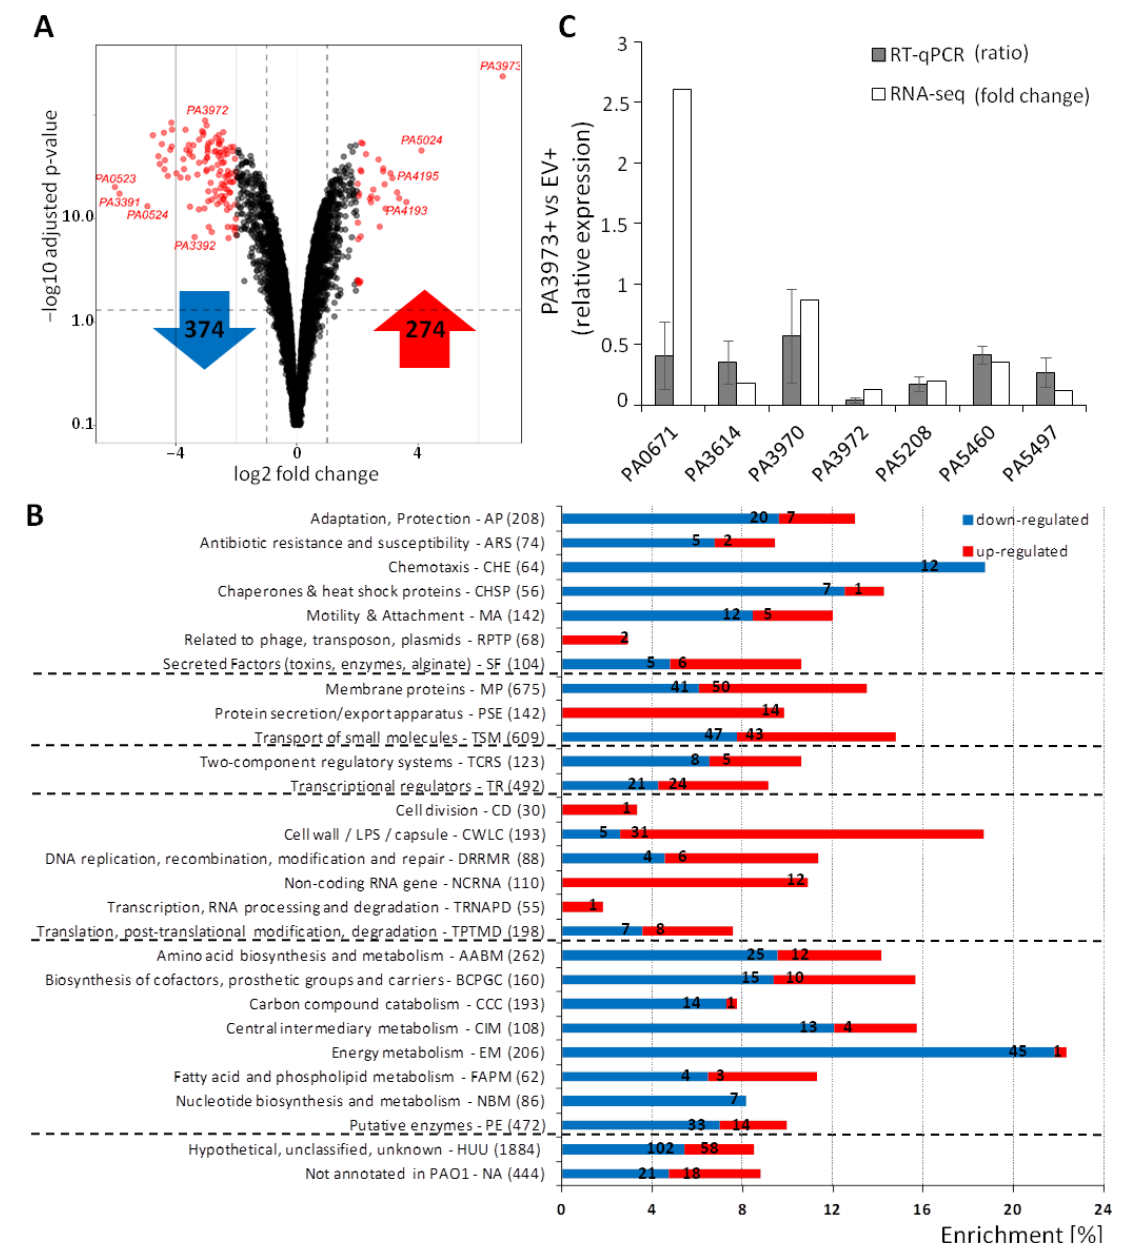
Figure 3. Identification of PA3973 dependent genes in P. aeruginosa using RNA-seq. Transcriptomes of PAO1161 cells carrying pKKB3.11 ( tac p- PA3973 ) or pAMB9.37 ( tac p), grown under selection in LB supplemented with 0.05 mM IPTG were analyzed by RNA-sequencing. ( A ) Volcano plot of RNA-seq data comparing the transcriptomes of PA3973+ and EV cells. Most significantly altered genes are indicated in red. The numbers of up- and down-regulated loci are presented in red and blue arrows, respectively. ( B ) Classification of loci (as in Table S3) with altered expression in response to PA3973 excess according to PseudoCAP categories [11]. The bars indicate the enrichment of genes belonging to each category relative to all genes from the category in the PAO1 genome. Numbers presented in red and blue bars correspond to the numbers of up- and down-regulated genes, respectively, in each category. ( C ) Validation of RNA-seq data by RT-qPCR analysis. The RT-qPCR was performed using RNA samples obtained for the same conditions of growth as samples used for RNA-seq analysis. The results of RNA-seq data are presented as a fold change according to data presented in Table S3, while RT-qPCR data represent the mean ratio ± SD for three biological replicates of PA3973+ cells relative to mean expression of the control EV+